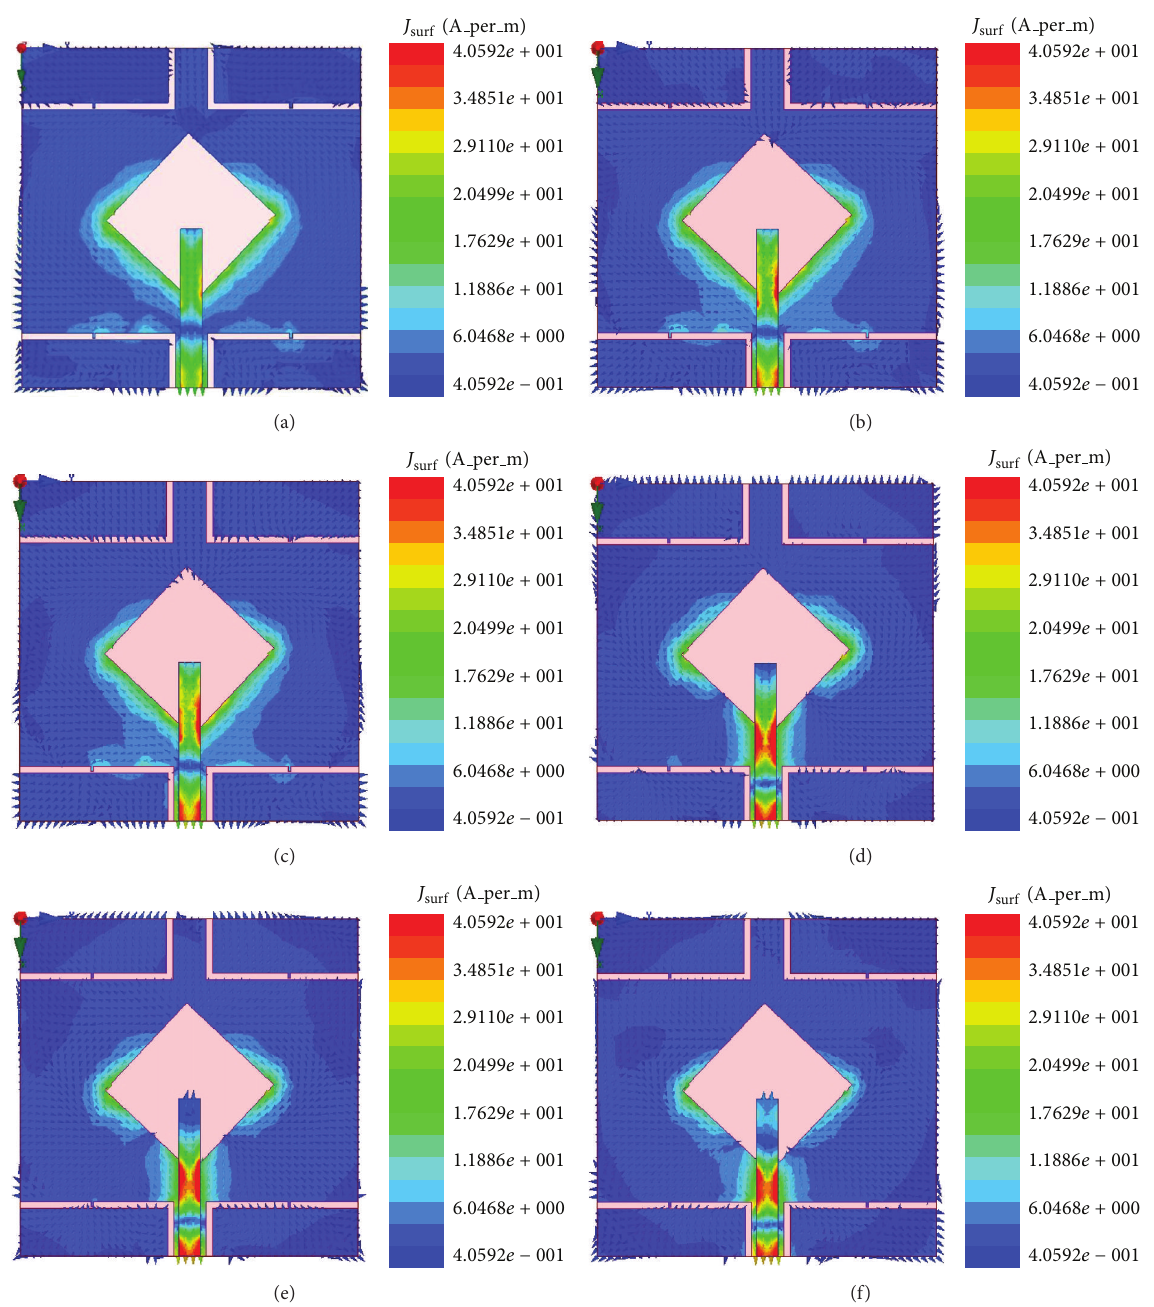
Figure 12: Surface current distribution of the proposed antenna at (a) 3.20 GHz, (b) 3.50 GHz, (c) 3.70 GHz, (d) 5.2 GHz, (e) 5.5 GHz, and (f) 5.8